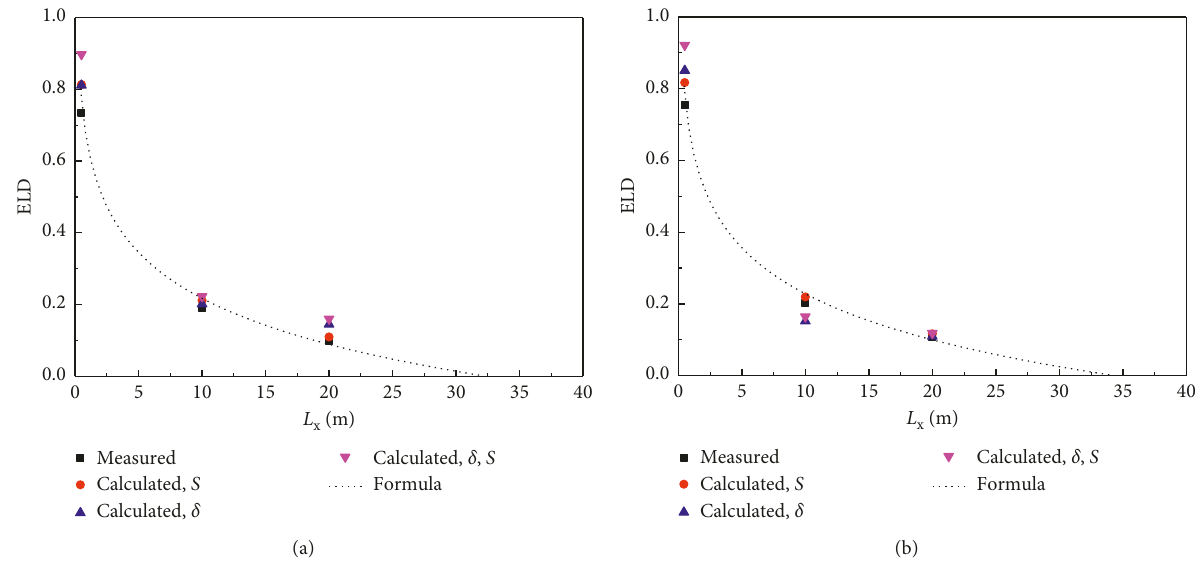
Figure 12: Relationship between the values of L